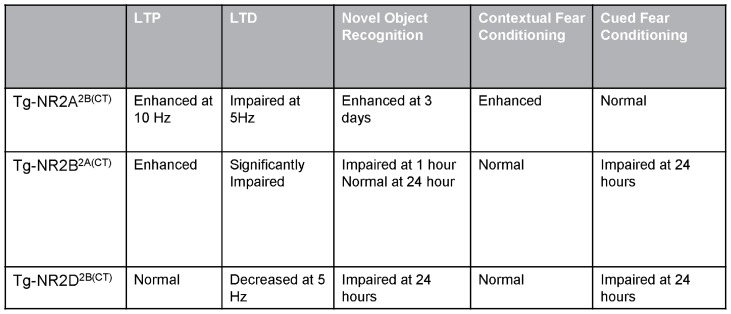
Summary of LTP, LTD and behavioral tasks results.The Tg-NRA2B(CT) mice had enhanced LTP, as well as enhanced long-term recognition memory and contextual fear conditioning. The Tg-GluN2B2A(CT) mice have significantly impaired LTD resulting in impaired short-term recognition memory and impaired long-term cued fear conditioning. The Tg-GluN2D2B(CT) mice have decreased LTD at 5 Hz and impaired long-term recognition memory and long-term cued fear memory.